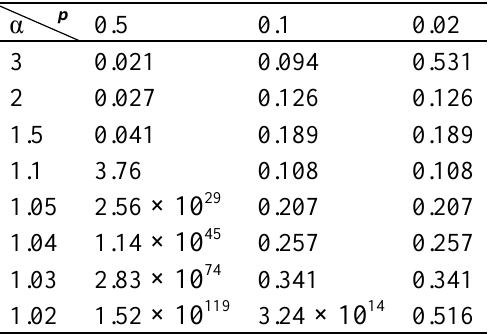
Table 2. Sample l p averages calculated by Algorithm 1 with window size 2 q + 1 = 13 for 2000-point data set from Distribution 2.